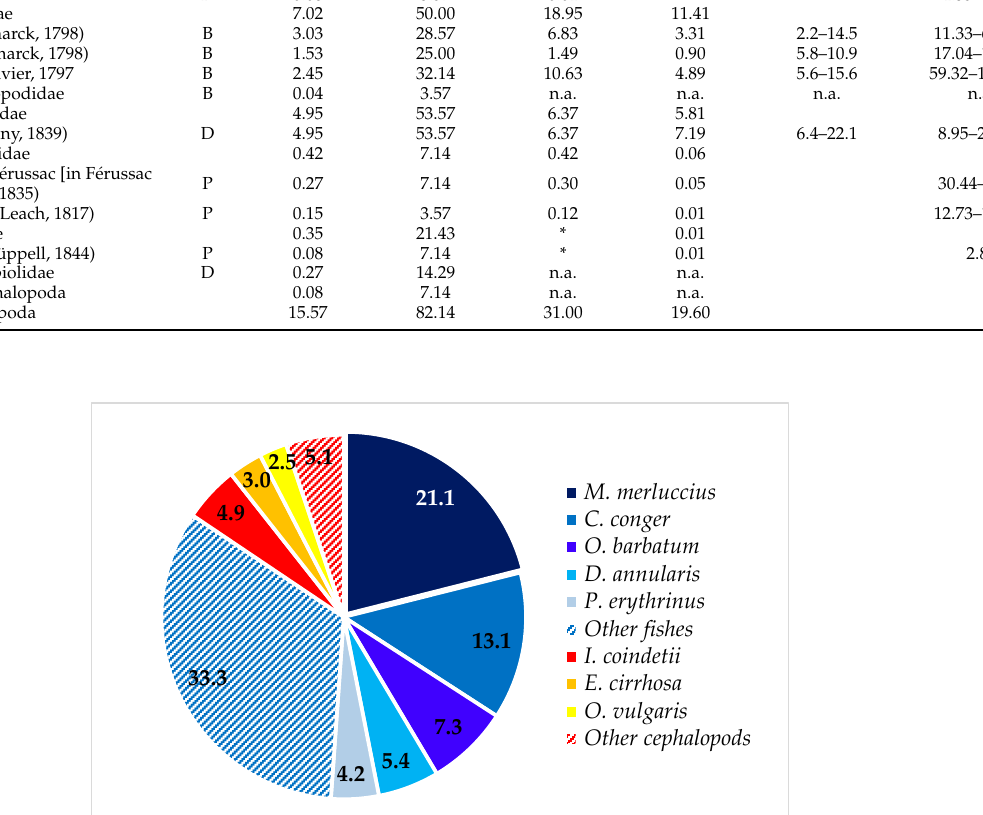
Figure 4. Weight percentage of main prey species found in T. truncatus stomachs. Concerning the size of bony fish prey, sizes ranged from 2 cm for species such as Lesueurigobius sp. to 60 cm for some specimens of conger eel. The abundance of fishes per size class is shown in Figure 5. The graph shows that more than 50% of specimens preyed upon by bottlenose dolphins measured 10.0–19.9 cm and 67.3% of these fishes have a de- mersal habit. Cephalopods are mostly represented by the shortfin broad tail squid, I. coindetii (%IRI = 7.2), and by the common octopus, O. vulgaris (%IRI = 4.9). Illex coindetii was the most abundant (Figure 5) and frequent among cephalopods; as a matter of fact, ca. half T. trun- catus fed upon I. coindetii (Table 2). Nevertheless, the common octopus represented 10.6% of the total weight (Figure 4) and Octopodidae (%IRI = 11.4%) were found to be the most important cephalopod family in the diet of analyzed bottlenose dolphins.